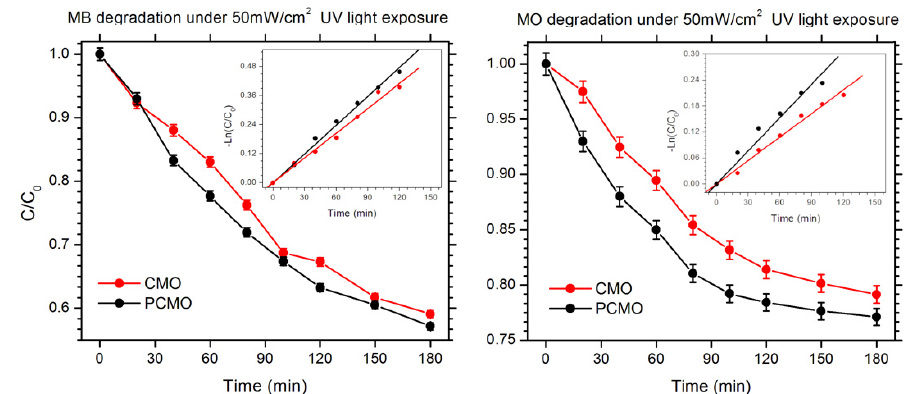
Figure 6. Photocatalytic decomposition of methylene blue ( left ) and methyl orange ( right ) over CMO and PCMO catalysts. The insets are the plots of Ln(C 0 /C) versus time. The slopes of these linear plots are used to obtain the values of k app summarized in Table